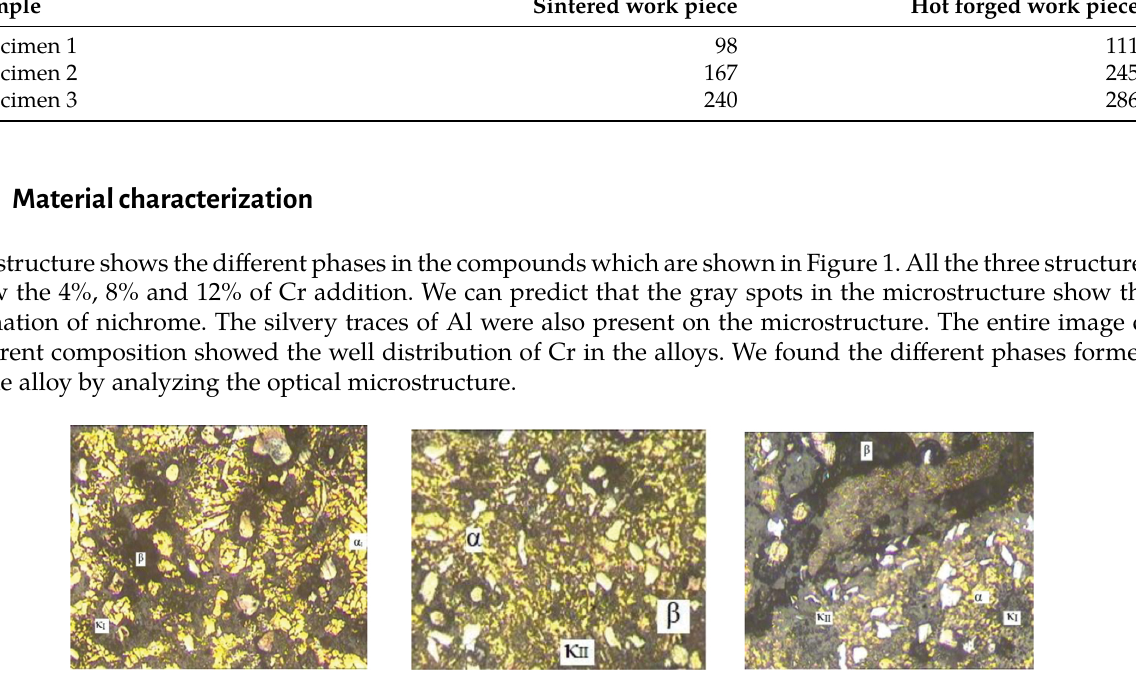
Figure 1: Showing the microstructure of 4%, 8% and 12% Cr